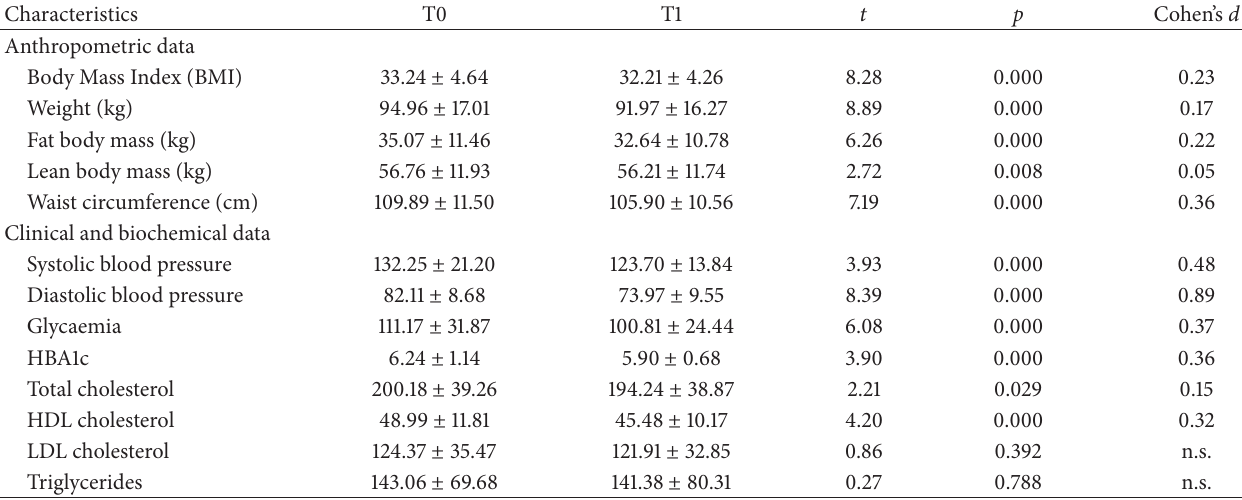
Table 1: Descriptive analysis of the obese patients at baseline and after the intervention. Data are presented as mean ± SD. Statistical significance was considered at 𝑝 < 0.05